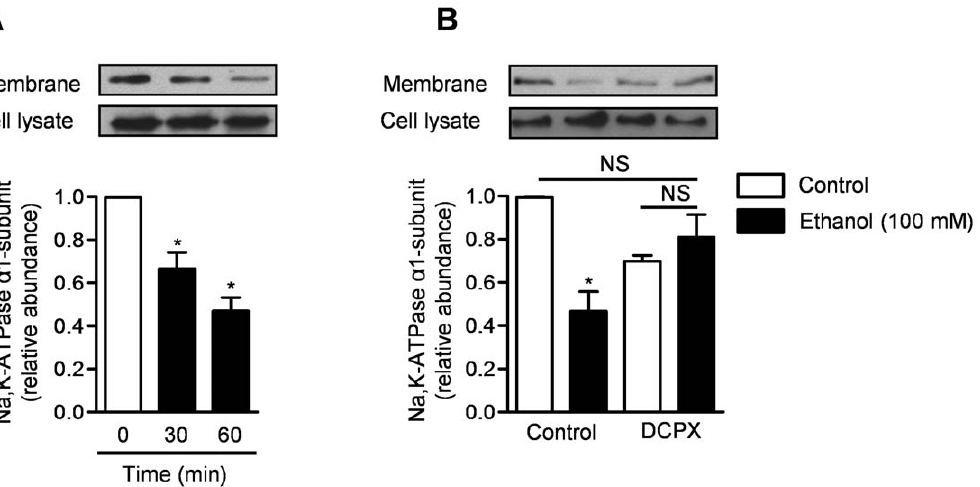
Figure 5. Alcohol-induced reduction in Na,K-ATPase is mediated via ADORA1. Membrane abundance of the a 1 -subunit of Na,K-ATPase was evaluated via immunoblotting membrane proteins (biotin pulldown) in primary rat AEC. ( A ) Cells were treated with an ADORA1 agonist (CPA, 10 2 5 M) at different time points. ( B ) Cells were treated with ethanol (100 mM) or control vehicle (sterile water) in the absence or presence of an ADORA1 antagonist (DCPX, 10 2 5 M). N $ 3 for all measures, *p , 0.05 for comparison with untreated cells.